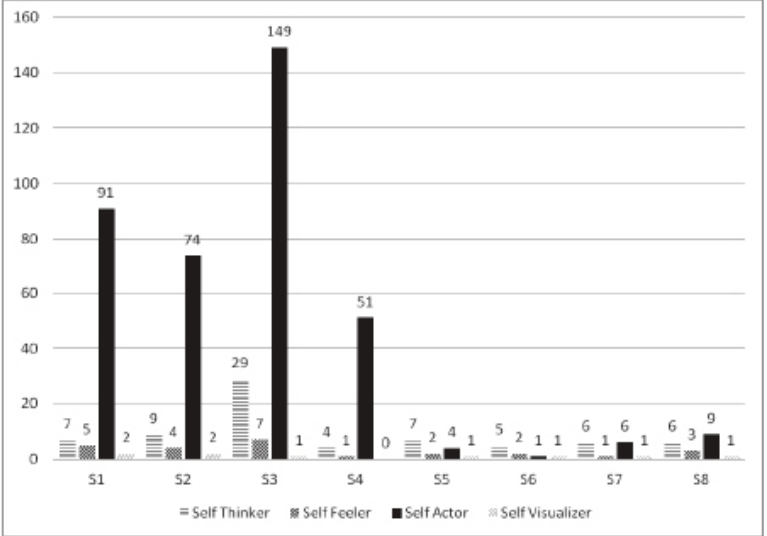
Figure 4. Numbers ofdifferent Imagine Selfroles adopted by each participant across